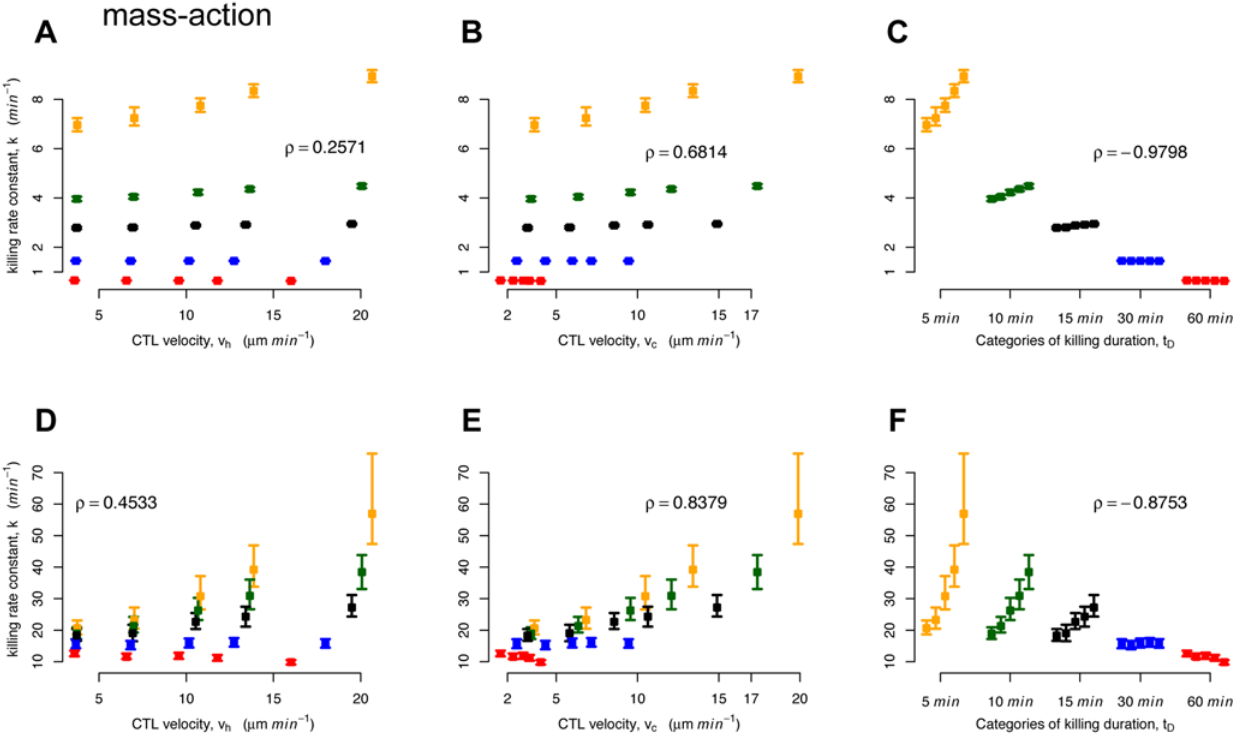
Figure 7. Plots of v h , v c and t D against the estimates of k . The estimation was based on either counting free and bound target cells (shown in A–C) or only free target cells (shown in D–F). The killing rate constant was estimated using the original method.The mean, the minimum and the maximum over 1000 estimates are shown (neglecting outliers) as the 95% confidence intervals are, in most cases, too small to be plotted. Spearman’s rank correlation coefficient, r , is given. The color coding corresponds to the different levels of t D (5 min (orange), 10 min (green), 15 min (black), 30 min (blue), 60 min (red)). In each group of t D in C and F, the level of velocity is increasing from left to right.